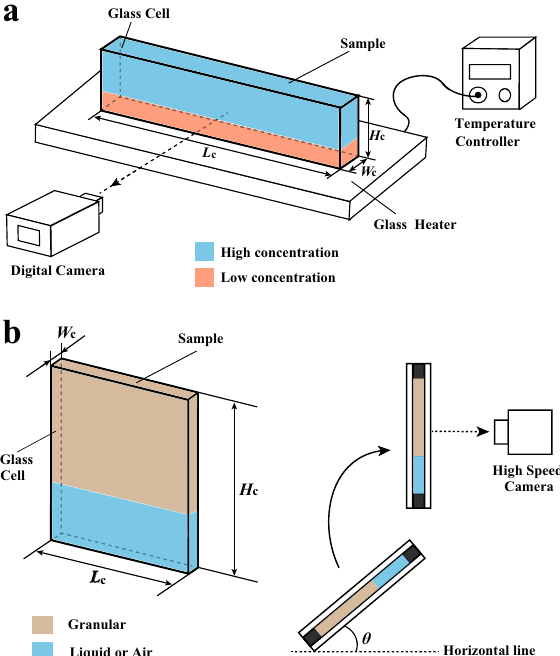
Figure 1. ( a ) Schematic of our experimental setup for gels. A glass sample chamber we use has internal dimensions (H, L, W) = (30 mm, 126 mm, 2.4 mm). Polystyrene latex microspheres are introduced into the upper layer to visualize the flow. Images were recorded with a digital camera. We control the bottom temperature T b by the heater. ( b ) Schematic of our experimental setup for granular systems. We put grains in the sample chamber (H, L, W) = (150 mm, 75 mm, 1.2 mm) or (90 mm, 65 mm, 2.4 mm) with sedimentation angle θ and then it is rotated